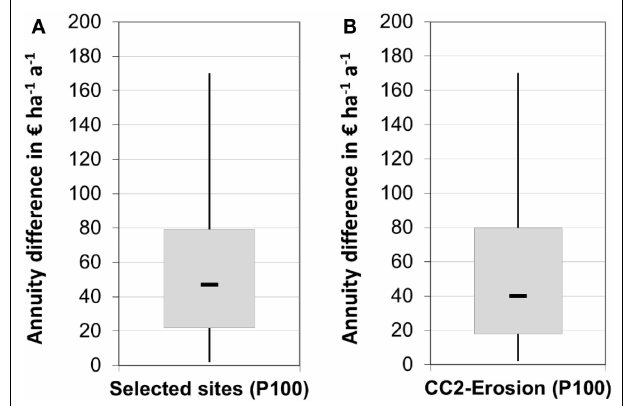
FIGURE 7 | Annuity difference between poplar SRC and a reference crop rotation (wheat-oilseed rape-barley) for (A) selected economically competitive sites with positive economic return in all scenario cases (P100), and (B) ecological synergy of erosion protection on these economically competitive sites .